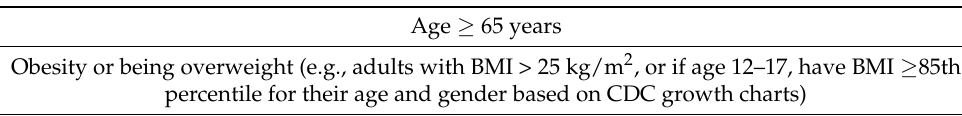
Table 1. Risk factors for progression to severe COVID-19 [47].